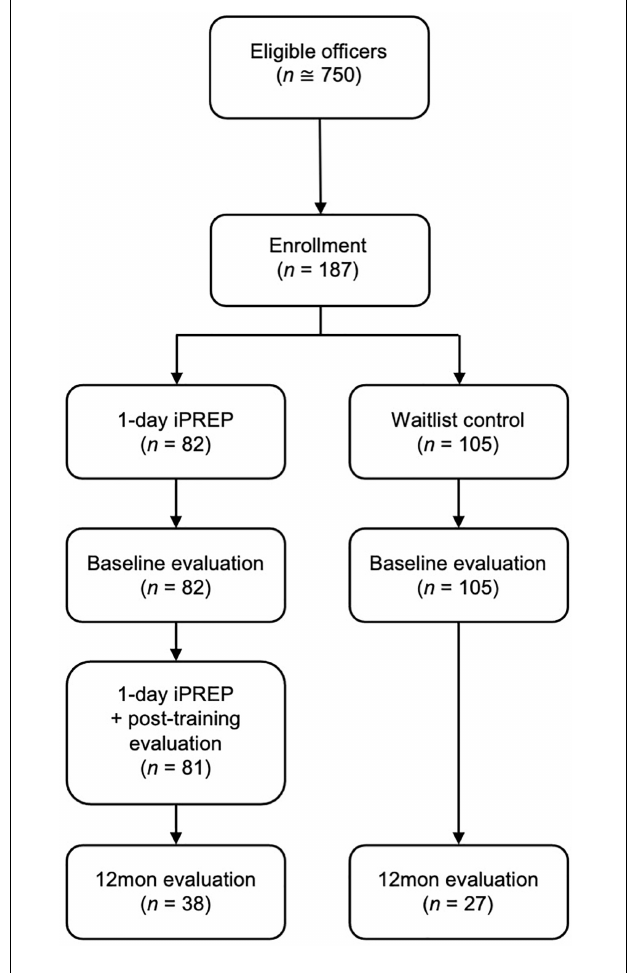
FIGURE 1 | Consort